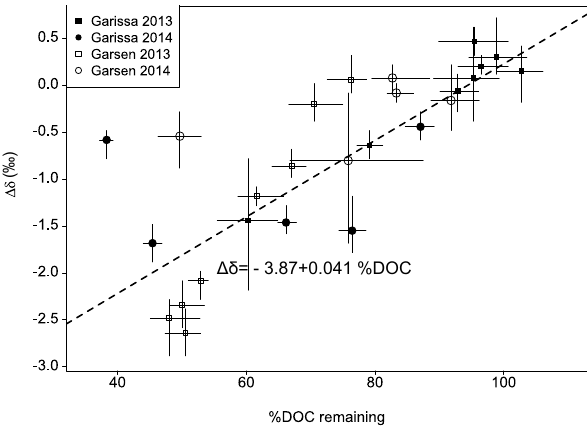
Figure 5. Change in isotopic signature between initial concentra- tion (day 0) and later in the incubation series ( (cid:49)δ ) vs. the propor- tion (%) of DOC remaining after incubation. The points are average values over the five measurements per series and the lines indicate minimum and maximum values within that series. A robust linear regression model was applied for the regression line. Both filtered and unfiltered series are represented.